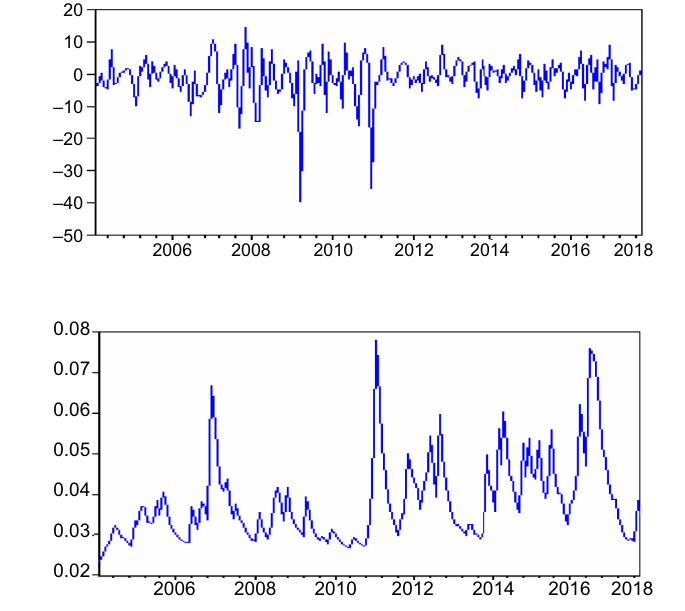
Figure 2. Evolution of Google search queries index